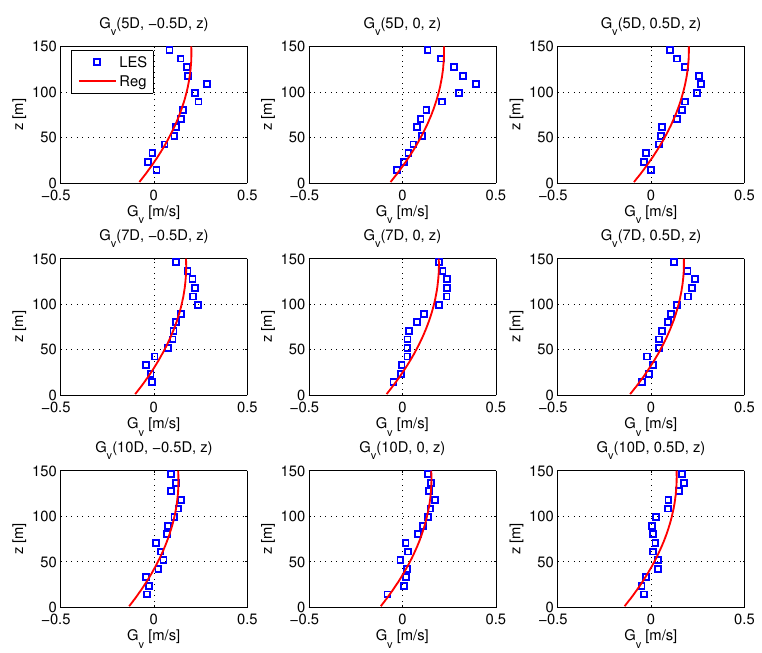
Figure 22. Spatial variation of G v : LES versus regression-based estimation.